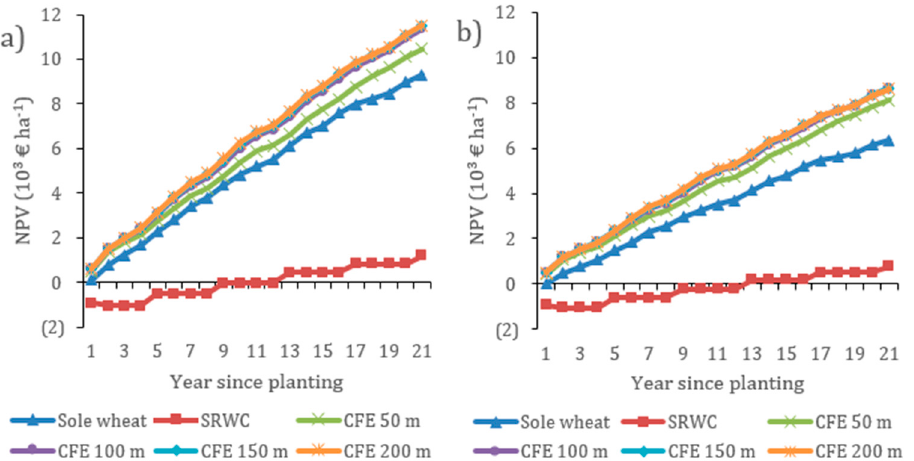
Figure 7. Net present value (NPV) for the six scenarios over 21 years for ( a ) a 10% increase in yield, and ( b ) a 10% decrease in yield.